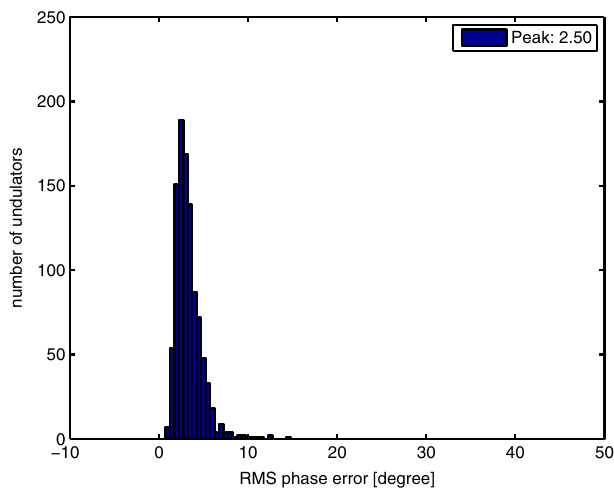
FIG. 10. (Color) Phase-error distribution for 1000 50-period undulators with a induction-shimming system misaligned by 0.5 mm against the zero crossings of the undulator main field; (cid:7) 3 (cid:6) 10 (cid:3) 3 (cid:7) (cid:2) B=B; coil ¼ (cid:2) B=B; pole ¼